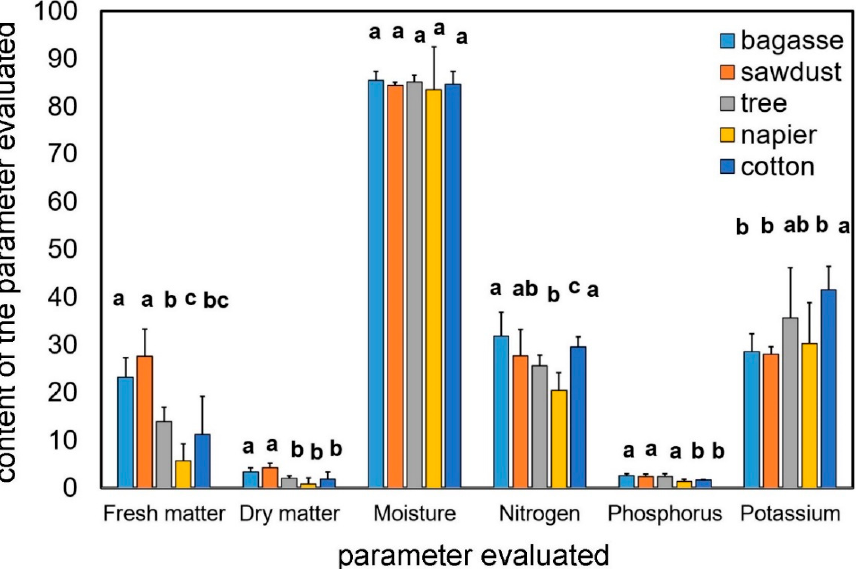
Figure 1. Growth (dry and fresh matter in g pot − 1 , moisture in %; y -axis) and mineral content (N, P, K in g kg − 1 ; y -axis) in shoots of parsley plants grown in medium composed of bagasse–chicken com-